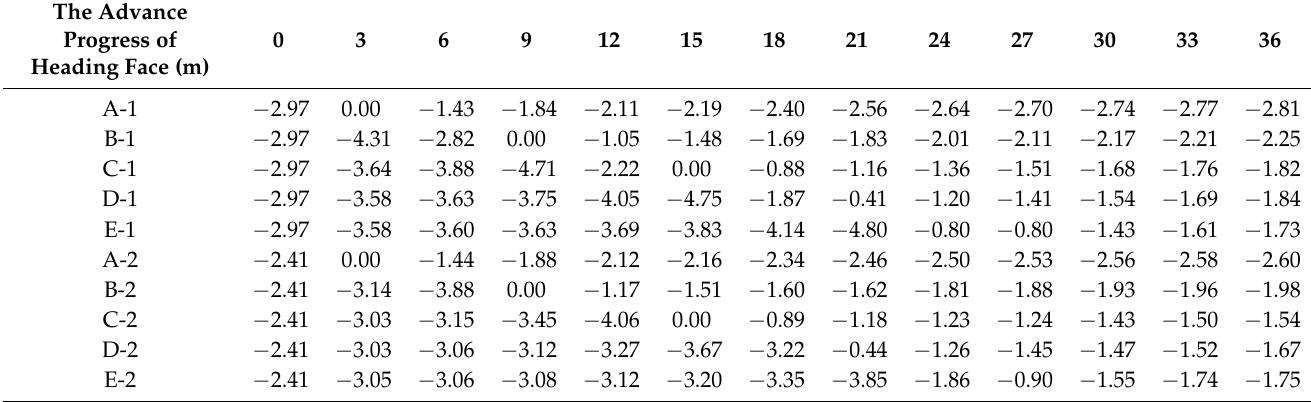
Table 11. Minimum principal stress trend of the second-layer initial support (Unit: